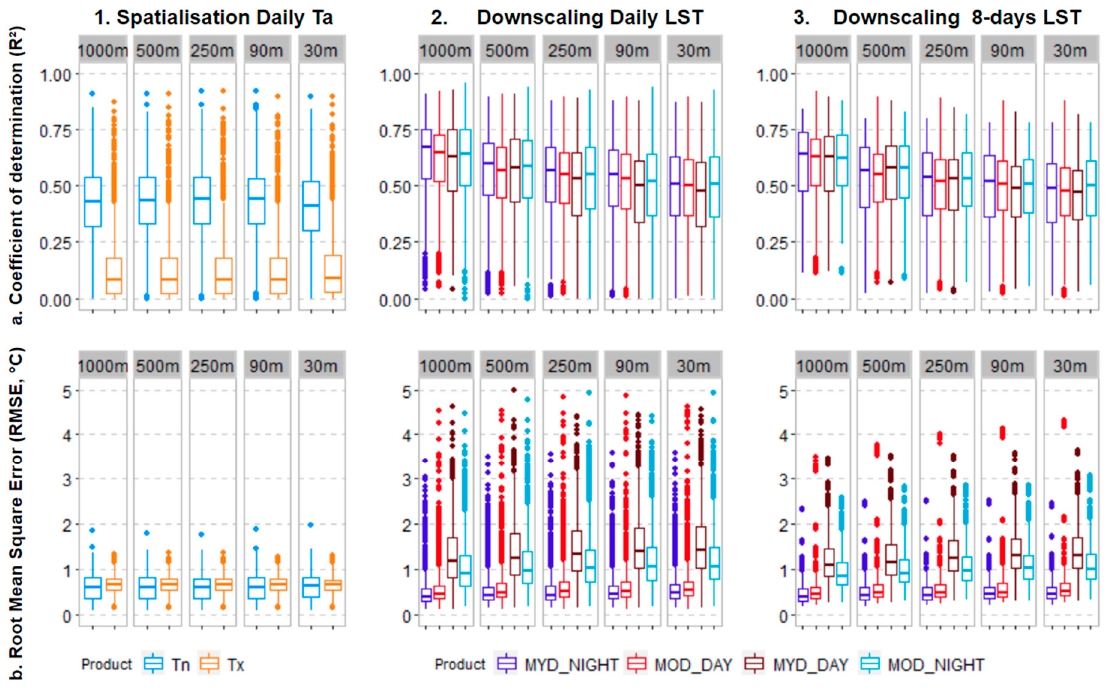
Figure 6. Boxplots of statistical indicators of the downscaling of (1) spatialization of air temperature, (2) downscaling of daily land surface temperature (LST) and (3) downscaling of the 8-day composite LST using the support vector machine algorithm gridded at different spatial resolutions, by the type of product for each year studied: ( a ) coefficient of determination (R 2 ) and ( b ) root mean square error (RMSE, in °C).